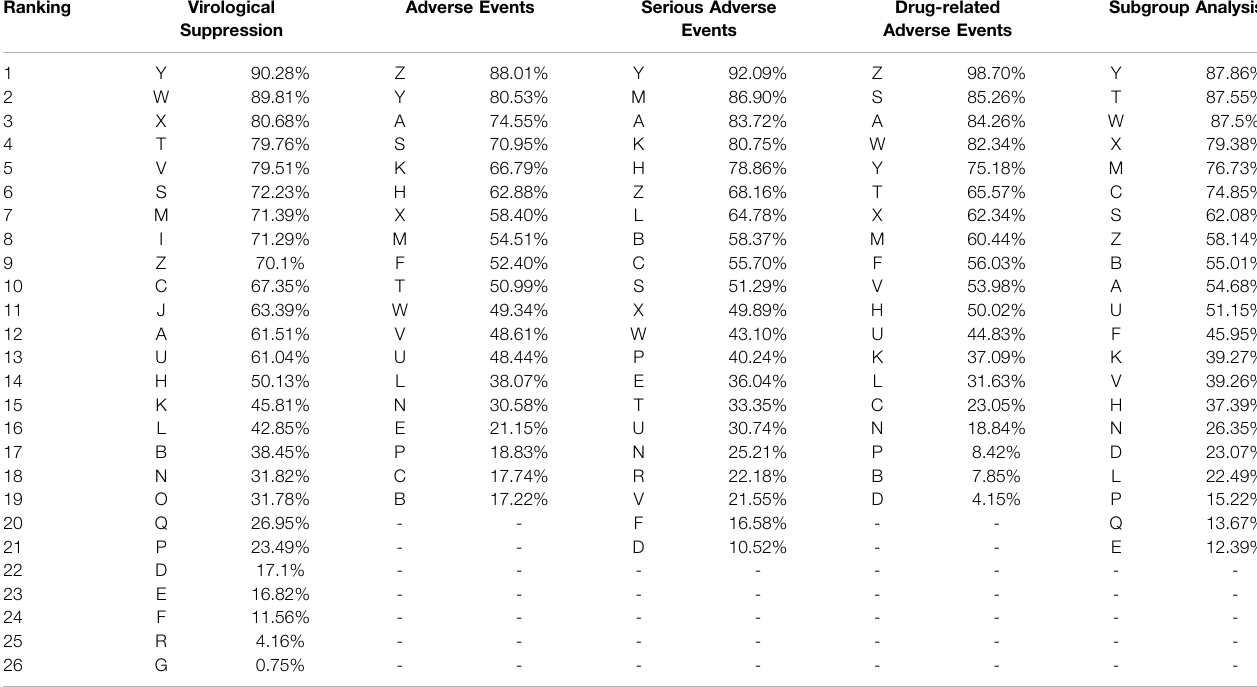
respectively. Table 1 shows the basic information for each trial and the baseline characteristics of the study population. The ARTs analyzed for each outcome are plotted in network plots, with straight line connections between the different ARTs indicating the existence of a RCT that directly compared the 2 ARTs ( Figure 2 ). Fixed-effect model was preferred for all the analysis, except analysis in adverse events.